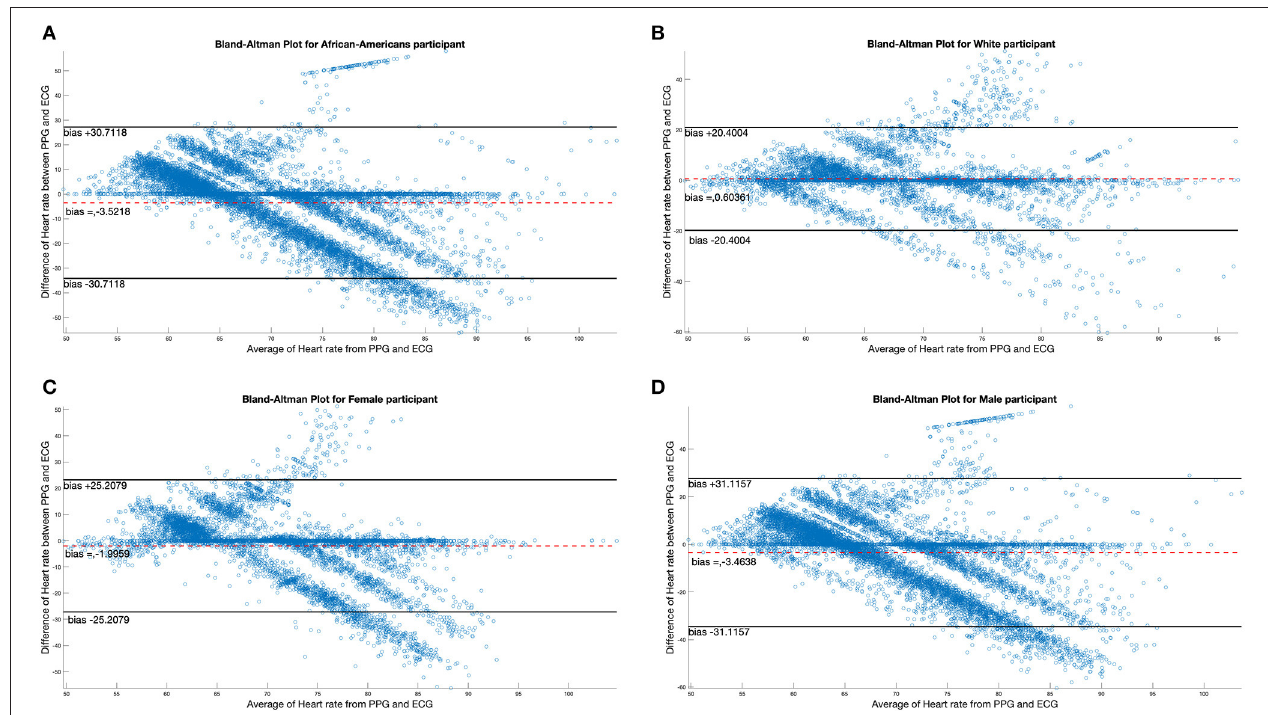
FIGURE 2 | Bland-Altman plots comparing differences in ECG data by race and gender. (A,B) Illustrate the Bland-Altman plots comparing the ECG chest sensor and wrist sensor for African American participants and White participants. (C,D) Show the Bland-Altman plots comparing the ECG chest sensor and wrist sensor for female and male participants.